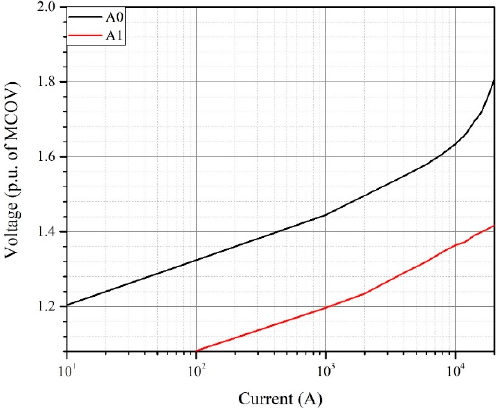
Figure 7. Residual voltage across non-linear resistors as a function of the impulse current.